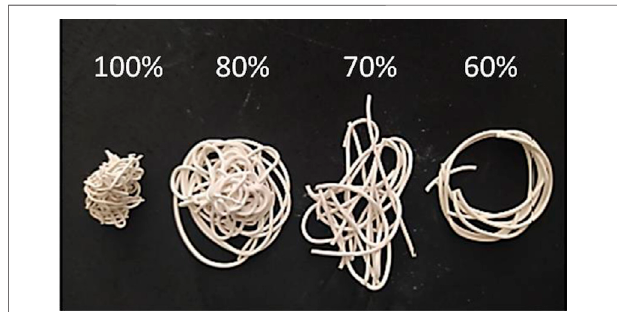
FIGURE 3 | Shear-thinning kaolinite dough suspension behaviors, for highest to lowest speed (%).